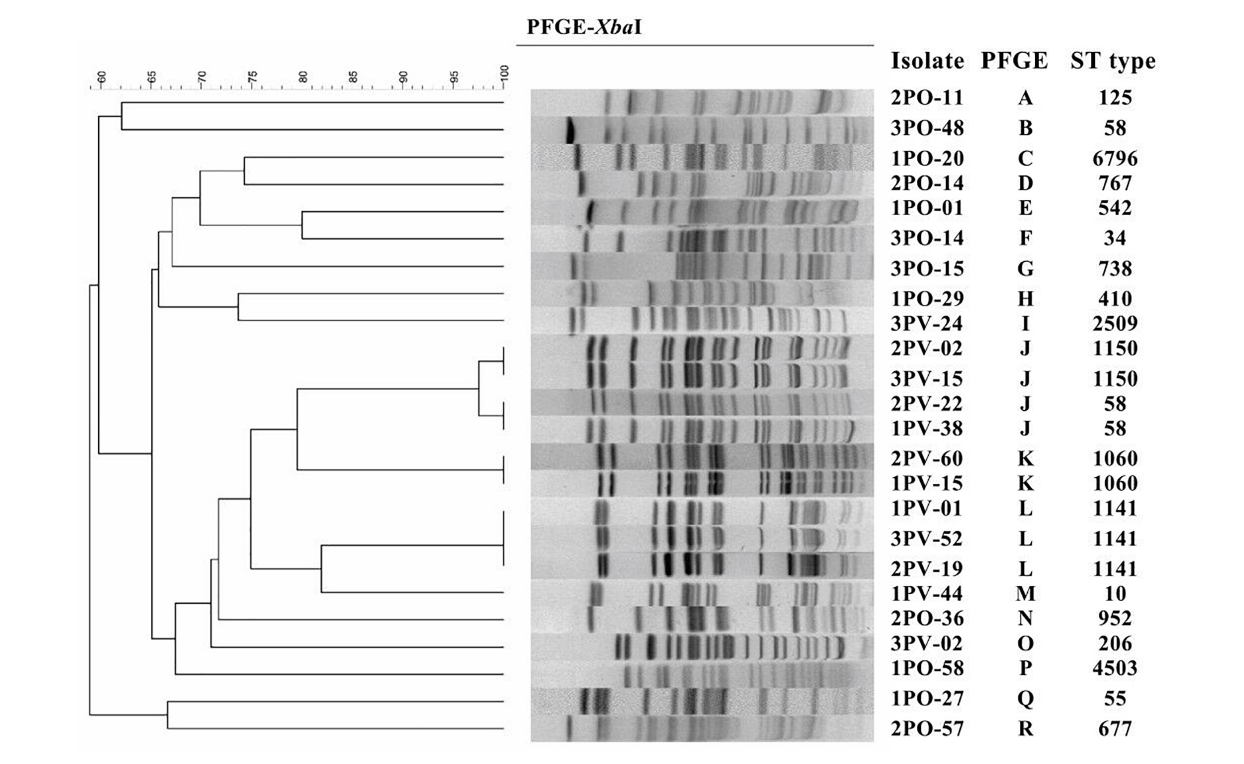
FIGURE 1 | Pulsed-field gel electrophoresis (PFGE) and multilocus sequence typing (MLST) of 12 sul -positive Escherichia coli isolates from Penaeus vannamei and 12 sul -positive E. coli isolates from pork